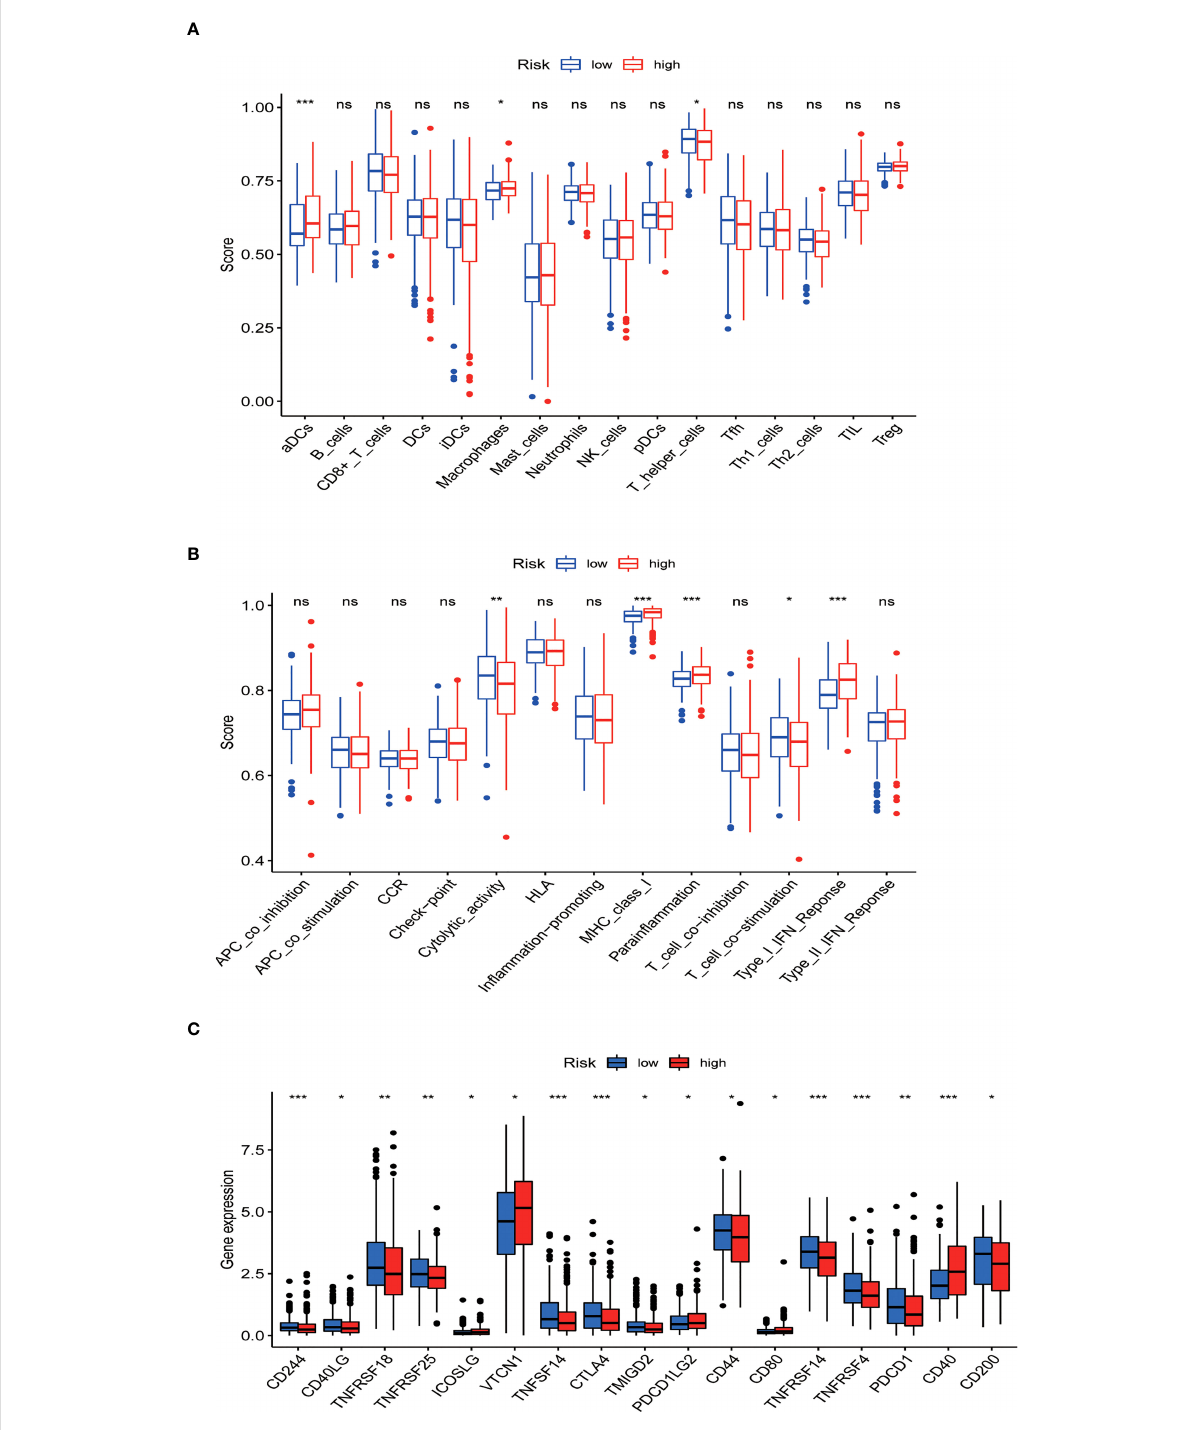
FIGURE 10 Tumor in fi ltrating immune cell and immune function. (A) Comparison between the immune cell in fi ltration levels in low- and high-risk groups. (B) Correlations between predictive signature and immune-related functions. (C) Differential expression of immune checkpoints in patients between low- and high-risk groups. *P<0.05, **P<0.01, and ***P<0.001. ns: not signi fi